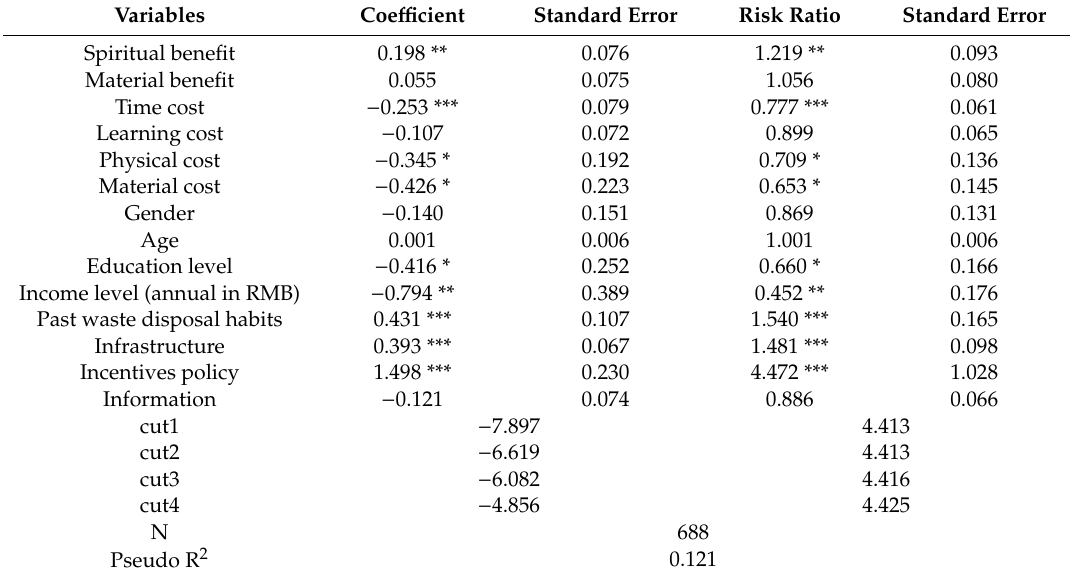
Table 4. The statistical value of influencing factors on the household waste sorting